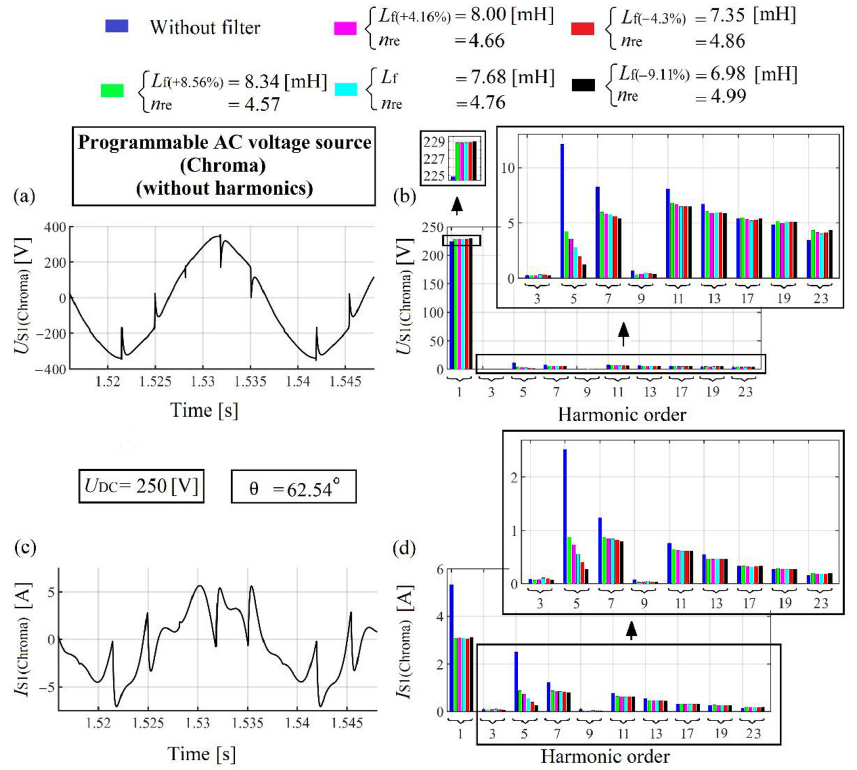
Figure 59. ( a ) PCC voltage waveform with the spectrum ( b ), ( c ) Chroma input current with the spectrum ( d